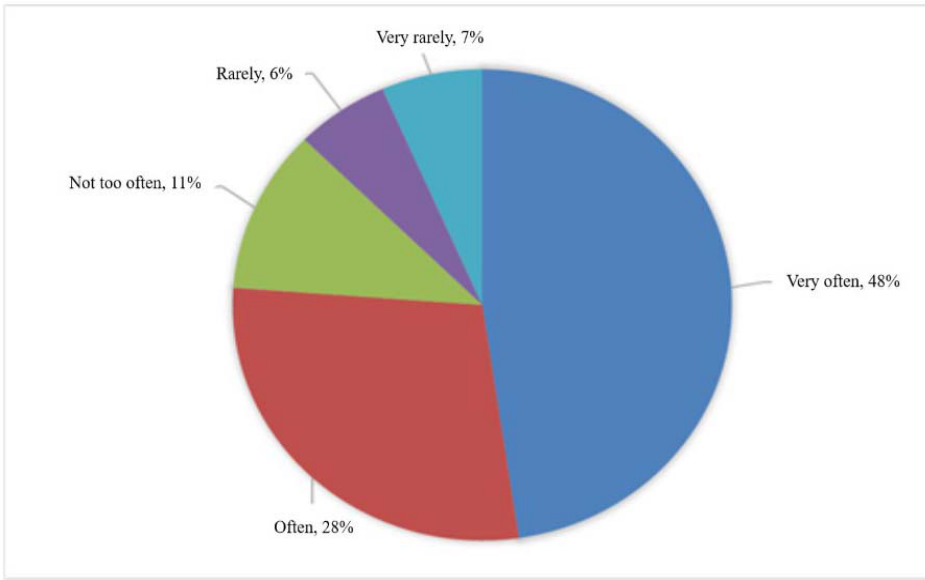
Fig. 5. Popularity of monolithic floors